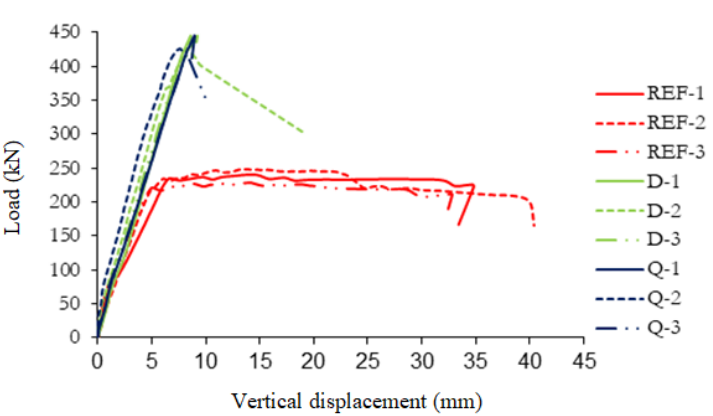
Figure 8. Graph of loads and vertical displacements for each tested beam.